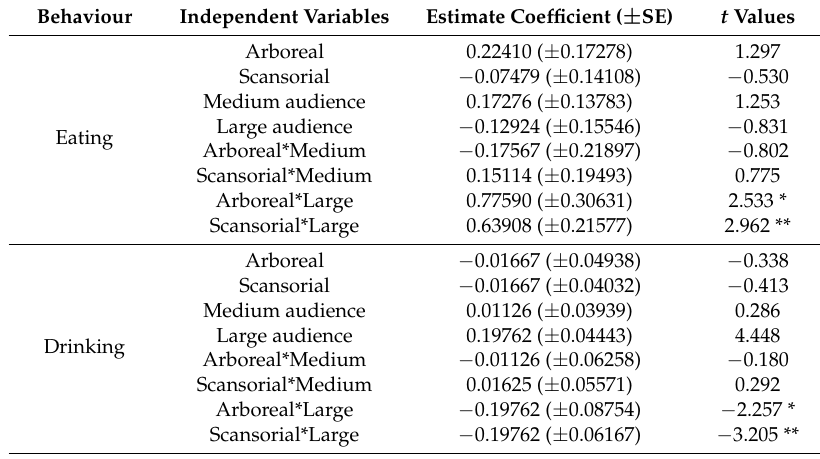
Table 7. Behaviours of zoo mammals significantly affected in the three types of stratum use (terrestrial, arboreal, and scansorial) and by public category (small, medium and